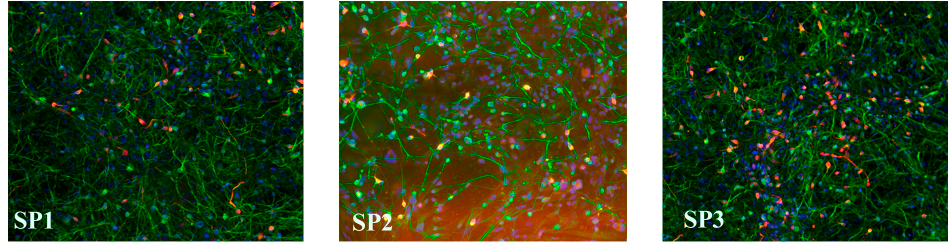
Figure 8. Immunocytochemical staining of DNs obtained by the cultivation of NPC on the CCs and MG using antibodies against TUBB (green), TH (red), and DAPI (blue). Representative photographs. Scale line is 100 μ m. 2.4. Influence of Cell Cultivation on CCs on Synaptogenesis in Emerging NPCs and IDNs The study of the transcription of marker genes responsible for synaptogenesis showed that the expression of the SNAP25 , STX1A , SNPT , SYN2 , and SYN3 genes did not differ significantly from all the CCs and MG used for the cultivation NPCs (Table 2). Table 2. Relation of the synapse-specific gene transcription levels in NPCs cultivated on CCs com- pared with MG. Coating SNAP 25 STX1A SNPT SYN2 SYN3 Docking of Synaptic Vesicles with the Membrane Synaptogenesis SP1/MG